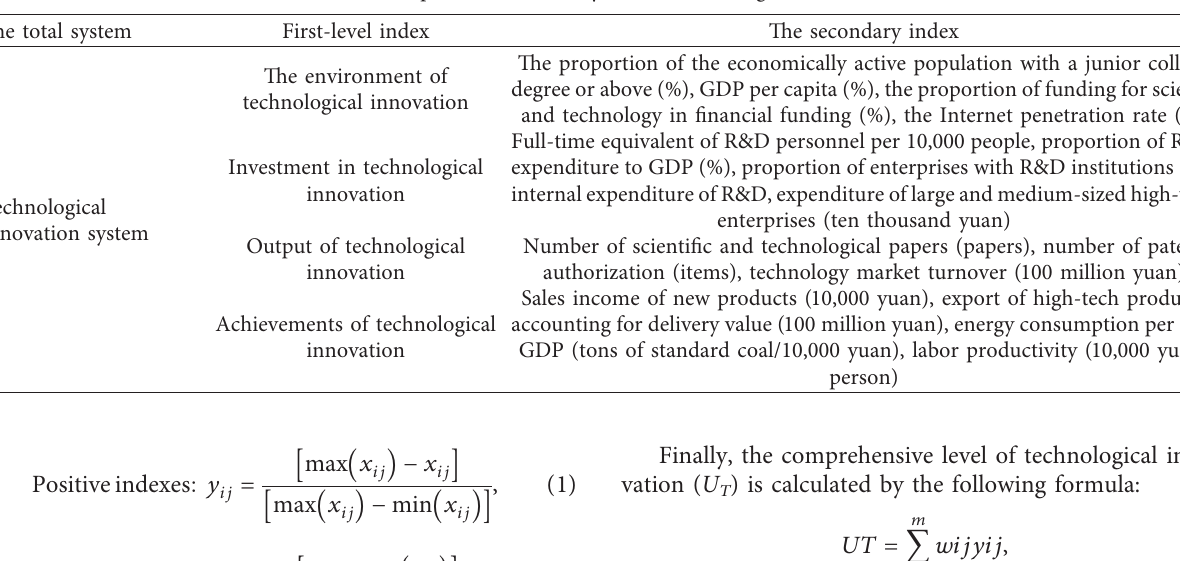
Table 1: Comprehensive index system of technological